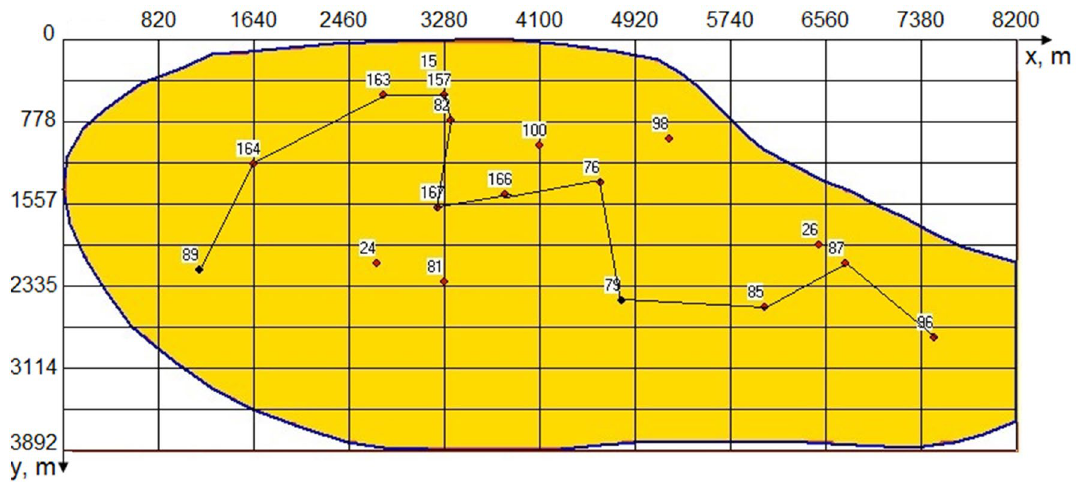
Fig. 2 Scheme of the Kotelevske natural gas